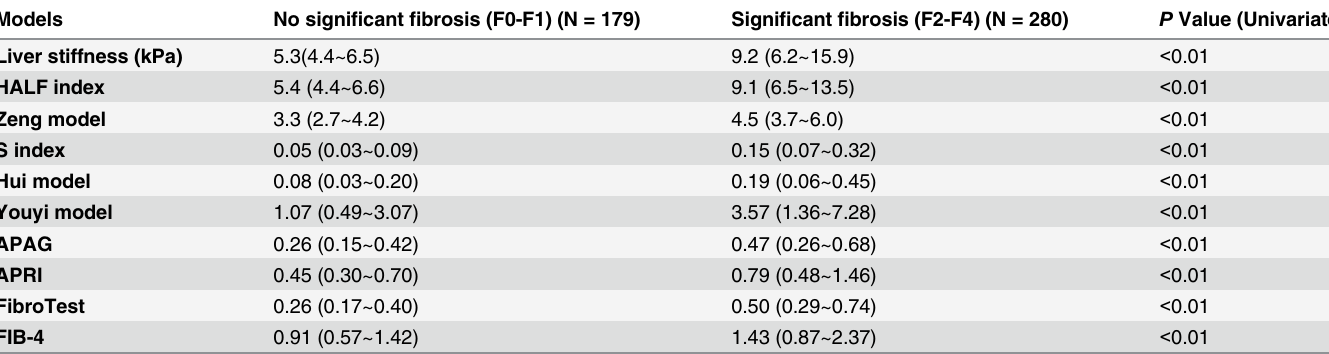
Table 3. Ten Models Associated With Presence of Significant Fibrosis (Stages 2 – 4) in All Patients. Models